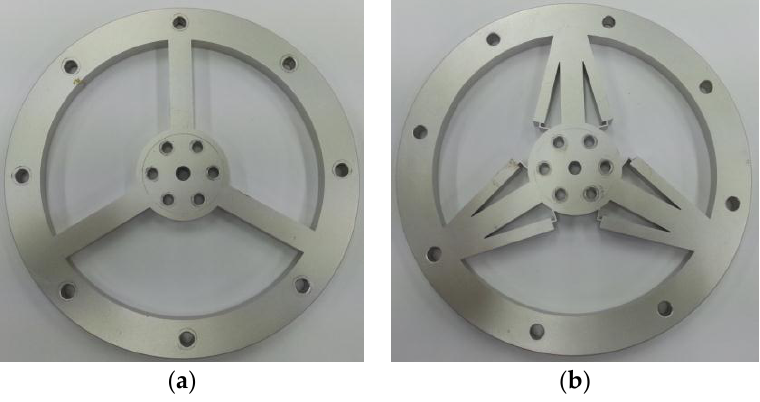
( d ) Figure 10. Deflection and strain FEA results of torque sensors. ( a ) Deflection of 3-beam sensor; ( b ) Deflection of TSHS; ( c ) strain of 3-beam sensor; ( d ) strain of TSHS. 4. Experimental Results 4.1. Experimental Equipment The actual 3-beam torque sensor and TSHS are both constructed to verify validity of the